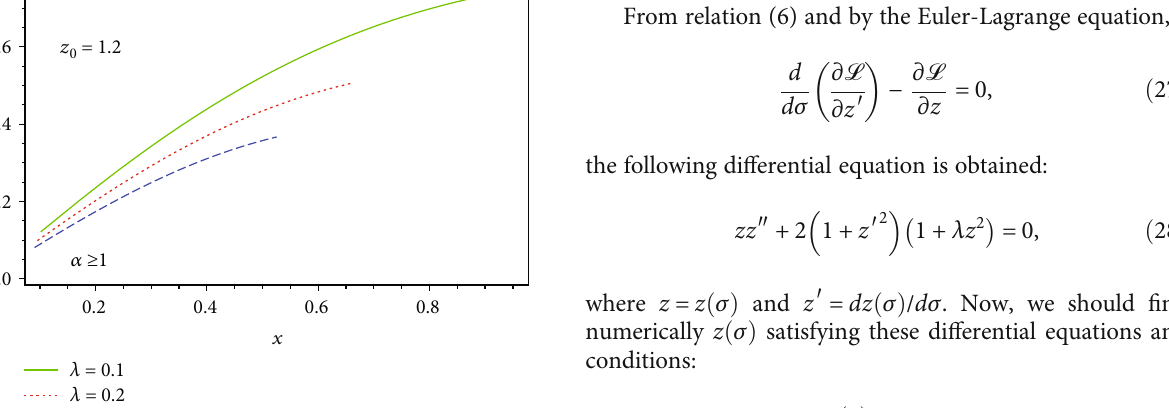
Table 1: Maximum values of V